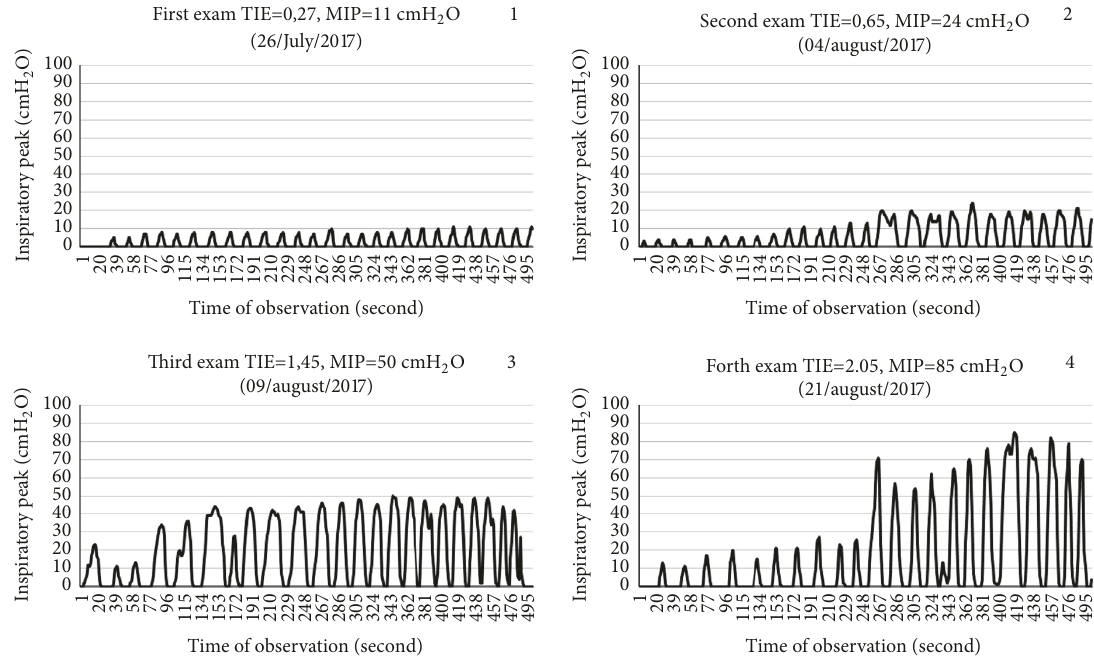
Figure 2: Graphics of inspiratory peaks in the serial weekly measurement of TIE index from the first until the last measurement along inspiratory muscle training